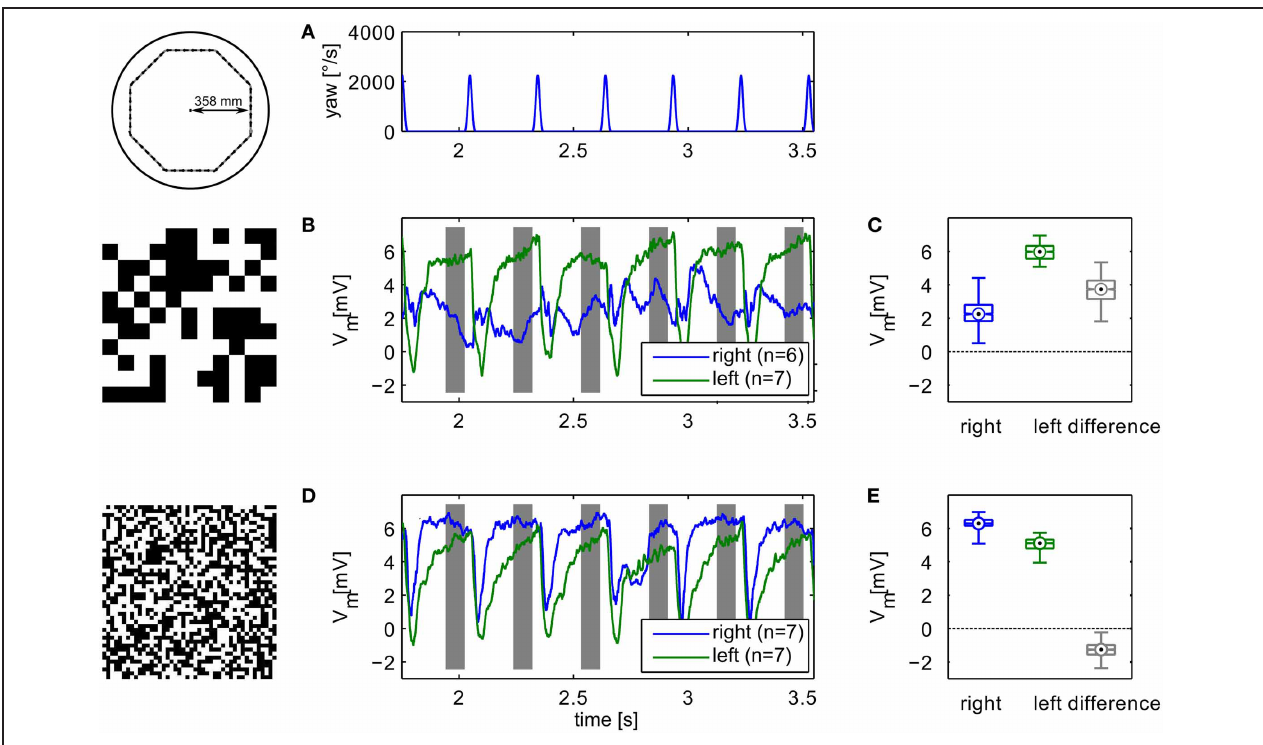
FIGURE 6 | Example of electrophysiological recordings. Left column (B,D) shows membrane potential changes relative to the resting potential of the cell obtained with the different textures. Top panel shows the yaw velocity timecourse (A) . Right column (C,E) shows boxplots of the responses in the